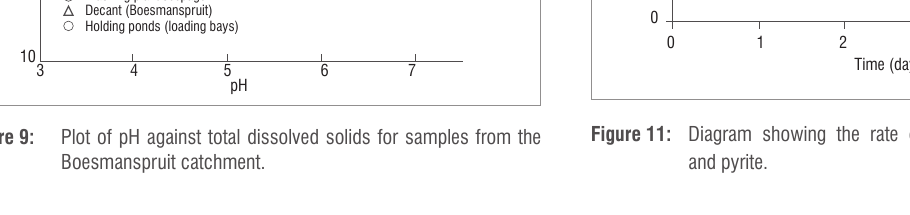
Average chemical composition (mg/L) of water samples collected from the catchment of the Boesmanspruit Dam